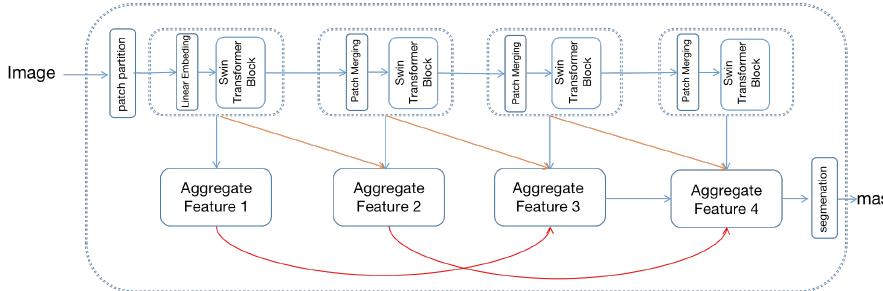
Figure 3. The framework of the proposed densely connect hierarchical Transformer. The top of the image is the swin-transformer and bottom is the hierarchical aggregation